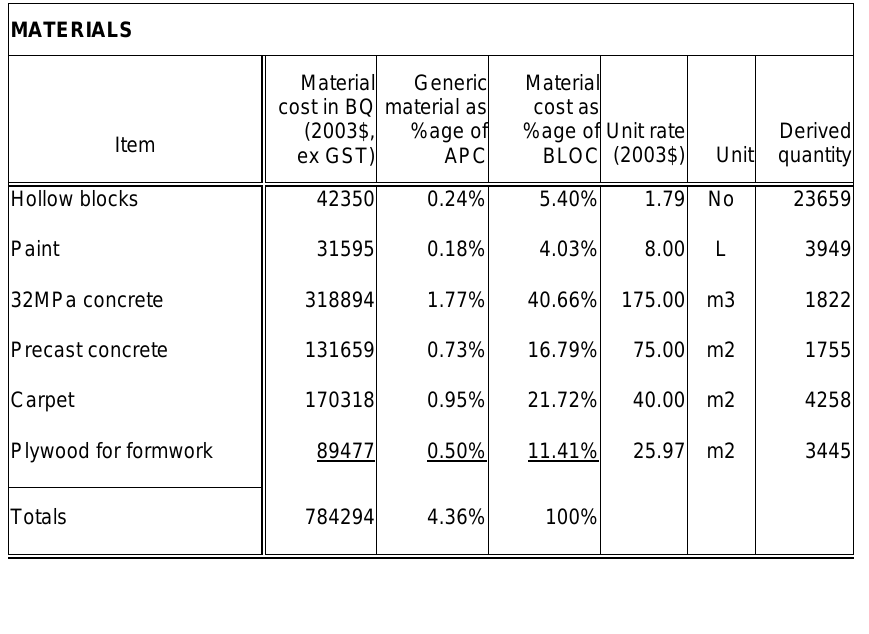
Table 1: Calculation of material quantities